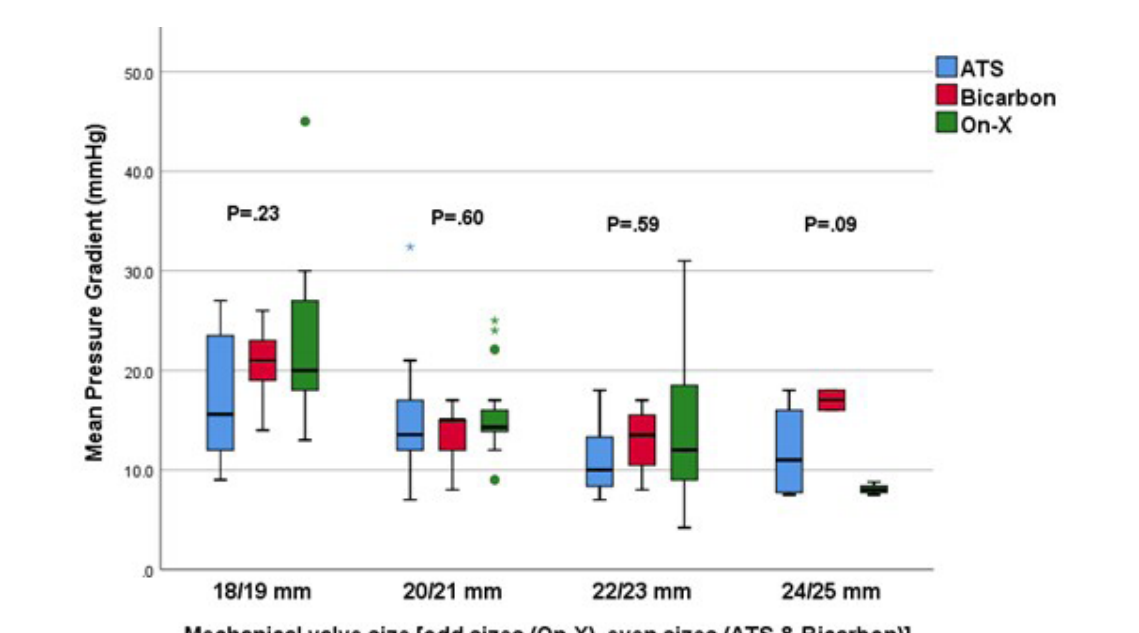
Fig. 1 - The mean pressure gradient of the aortic prostheses postoperatively based on pre-discharge transthoracic echocardiography (TTE) for different valve sizes (18/19 mm, 20/21 mm, 22/23 mm, and 24/25 mm). Size 16 and size 26/27 are not shown in the graph due to small numbers. Even number sizes are for Bicarbon and ATS AP360 valves, while odd number sizes are for On-X. The grouping of the On-X with the Bicarbon and ATS AP360 was based on the nearest external diameter.